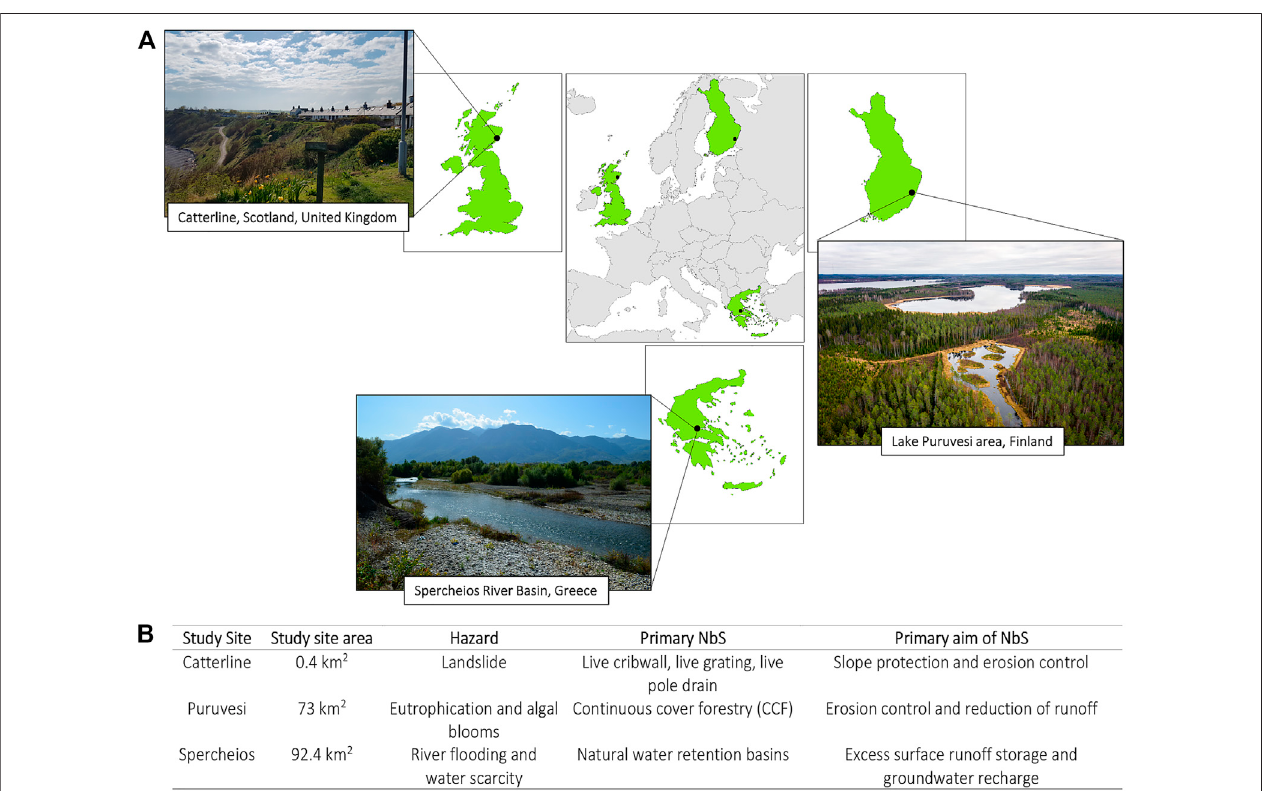
FIGURE 1 | Three European NbS study sites (A) and their characteristics, including hazard type and primary NbS being implemented within the OPERANDUM project (B) . Map: European Commission, Eurostat, https://ec.europa.eu/eurostat/web/gisco/geodata/reference-data/administrative-units-statistical-units/countries. Photo credits: Catterline, Dr Karen Munro; Puruvesi, Pro Puruvesi ry; Spercheios, KKT-ITC